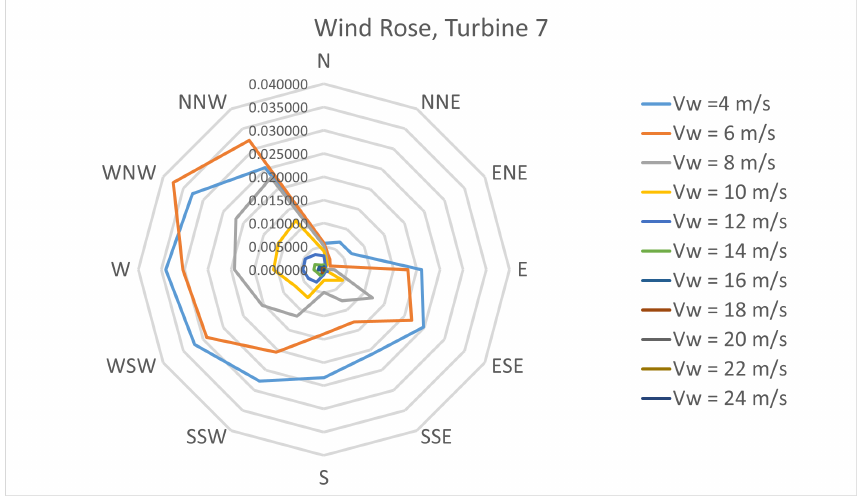
Figure A4. Wind Rose 7—wind speed and wind direction probability for wind turbine